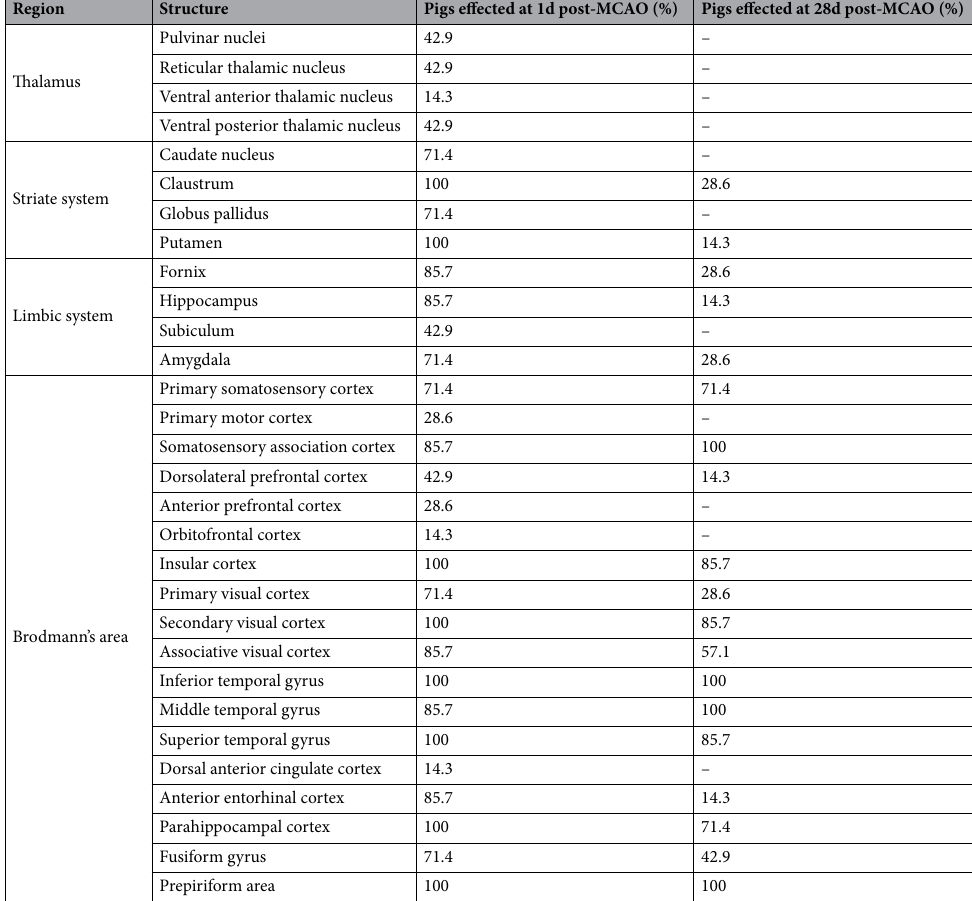
Table 1. Percentage of pigs with lesion in each structure. Identified structures were separated into regions including the thalamus, striate system, limbic system, and Brodmann’s Areas. Activated pixels in each structure signified positive lesion. Lesion locations were identified at 1d and 28d post-MCAO. 100% signifies that all pigs (n = 7) had lesion in